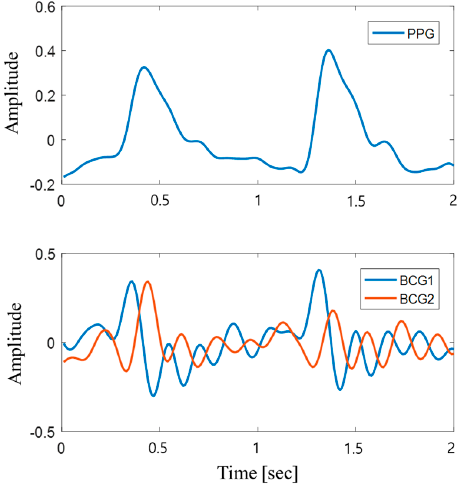
Figure 2. Photoplethysmogram (PPG) signals measured using the developed system as reference signals, which indicate whether the peaks of the BCG are working properly. BCG1 and BCG2 refer to the signals measured from the back and seat plates, respectively.